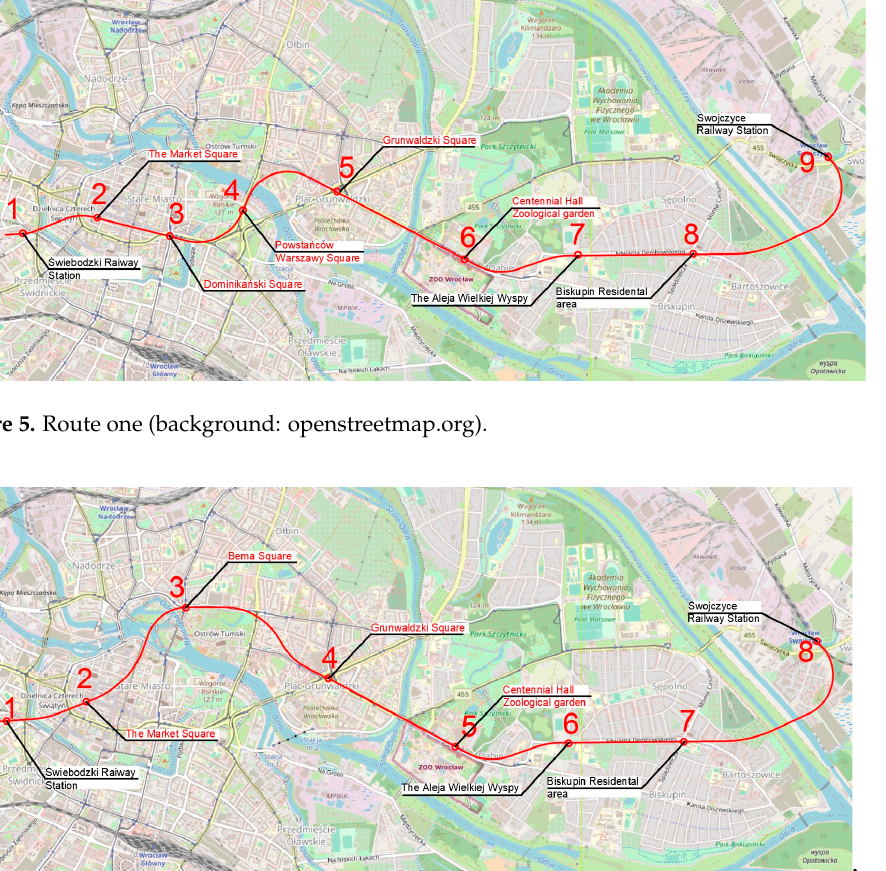
Figure 6. Route two (background: openstreetmap.org).